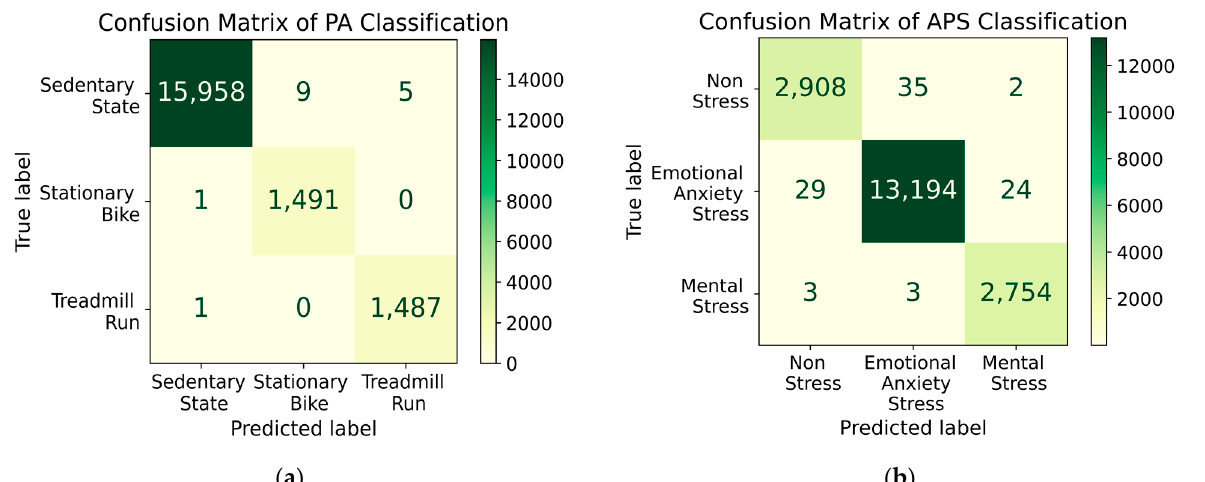
Figure 6. ( a ) Confusion matrix of PA types classification using the multi-task LSTM RNN classification of APS types and PA types (class imbalance mitigated by weighted training); ( b ) Confusion matrix of APS types classification using the multi-task LSTM RNN classification of APS types and PA types (weighted training).